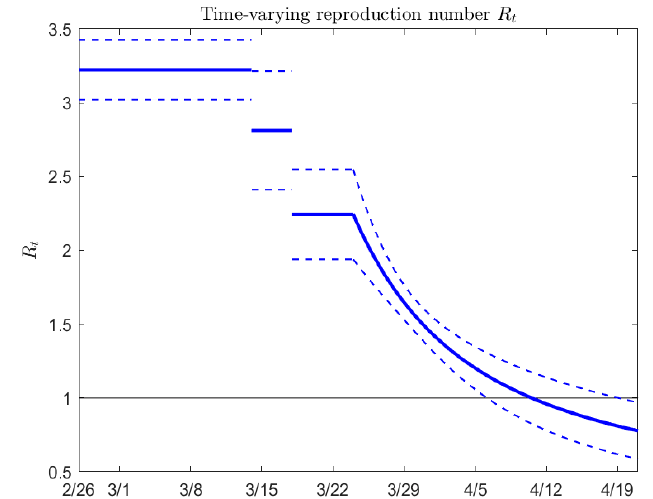
Figure 3. Estimated e ff ective reproduction number R t in Ontario, Canada as a function of time (mean value and 95% confidence interval).